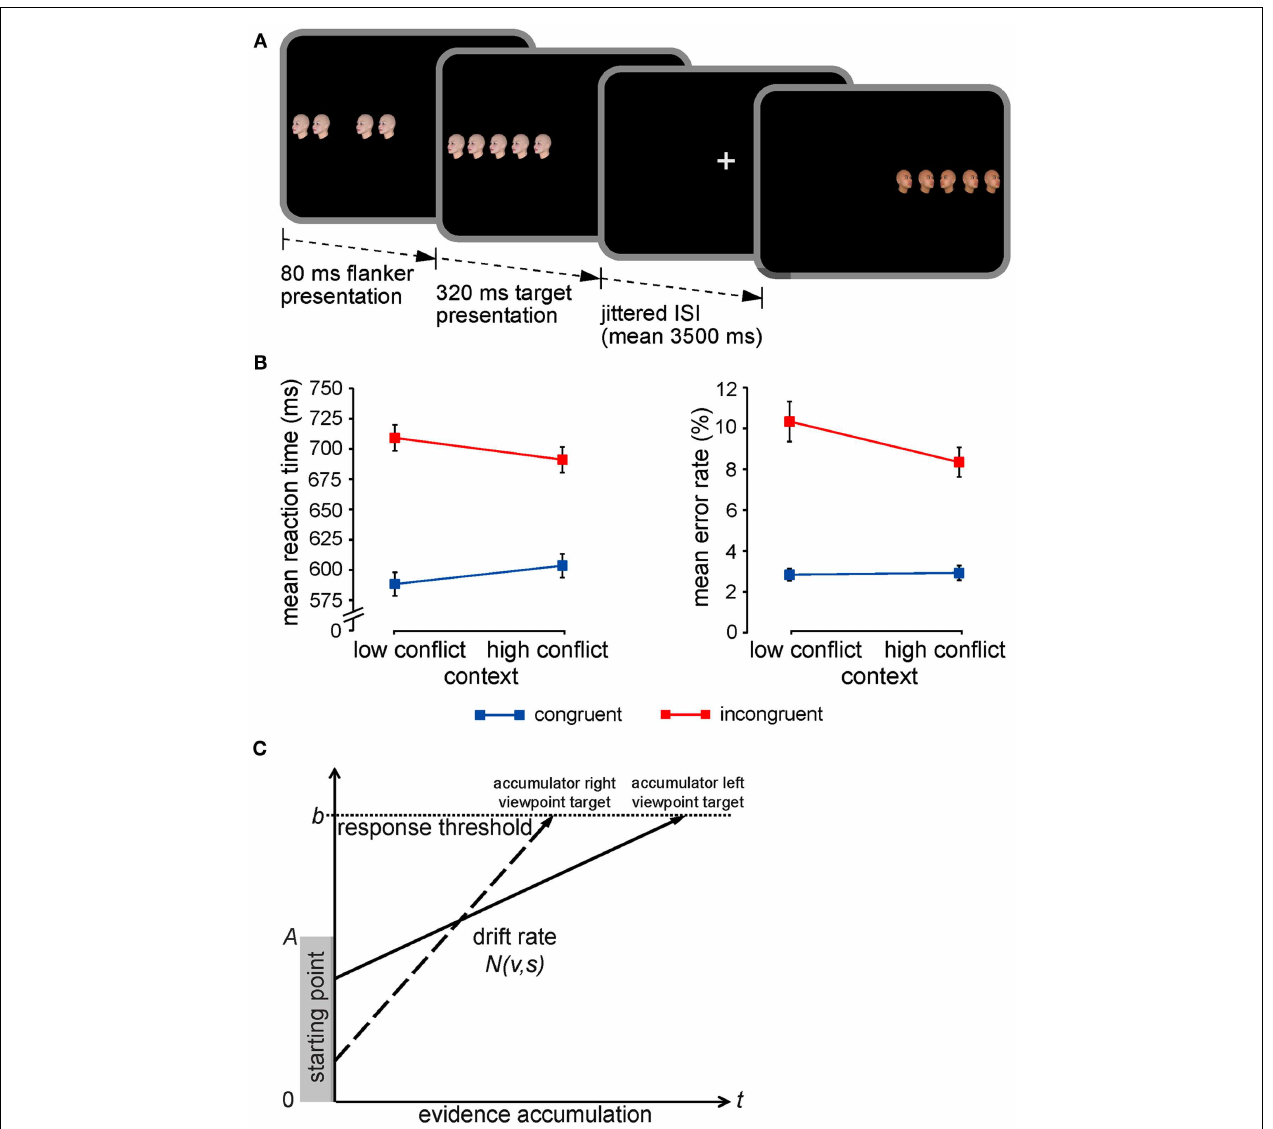
error rates ( ± SEM) are plotted for flanker congruent and incongruent trials as a function of the contextual conflict-frequency manipulation, illustrating the critical context × congruency interactions (i.e., CSPC effects). (C) The LBA model as applied to a typical decision in the face-viewpoint flanker task. One accumulator corresponds to the response that the target face is pointing left (solid arrow), while the other accumulator corresponds to a rightward response (dashed arrow). A response is triggered as soon as an accumulator reaches the response threshold, b (horizontal dotted line). Each accumulator begins with a starting amount of evidence drawn randomly from the range indicated by the gray-shaded rectangle (between 0 and A ), and the accumulation rate (i.e., drift) for each response is drawn from a normal distribution with an appropriate mean, v , and SD, s